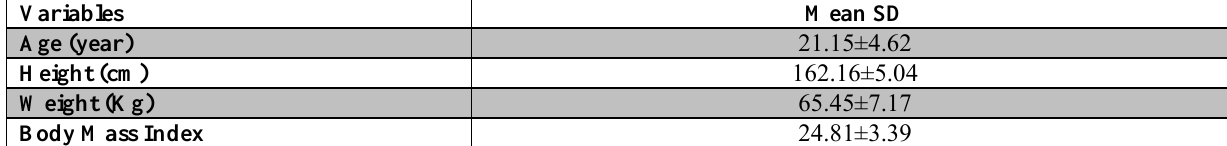
Demographic characteristics of study subjects (n =